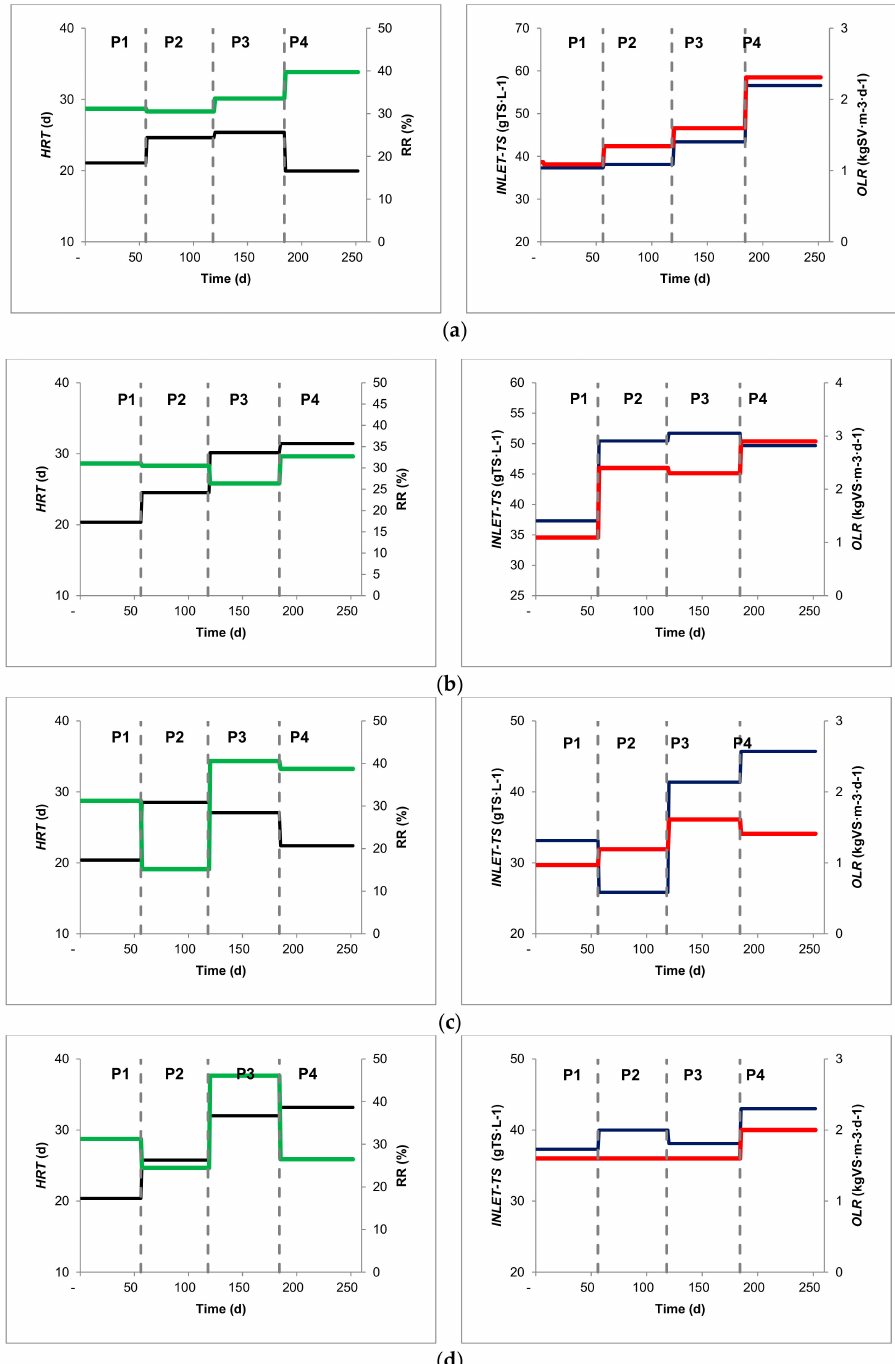
Figure 2. Operational parameter: Hydraulic retention time ( HRT ), recirculation rate ( RR ), inlet total solids content ( inlet-TS ), and organic loading rate ( OLR ) per reactor and period. ( a ) R1; ( b ) R2; ( c ) R3; ( d ) R4. Note: Vertical grey lines denote periods; black lines denote average HRT per period; green lines denote average RR per period; blue lines denote average inlet-TS per period; red lines denote average OLR per